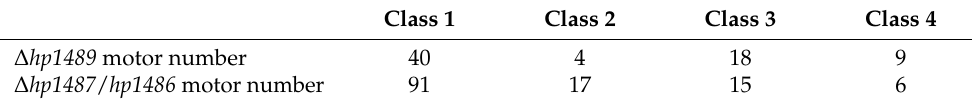
Table 2. Number of subtomograms for each motor